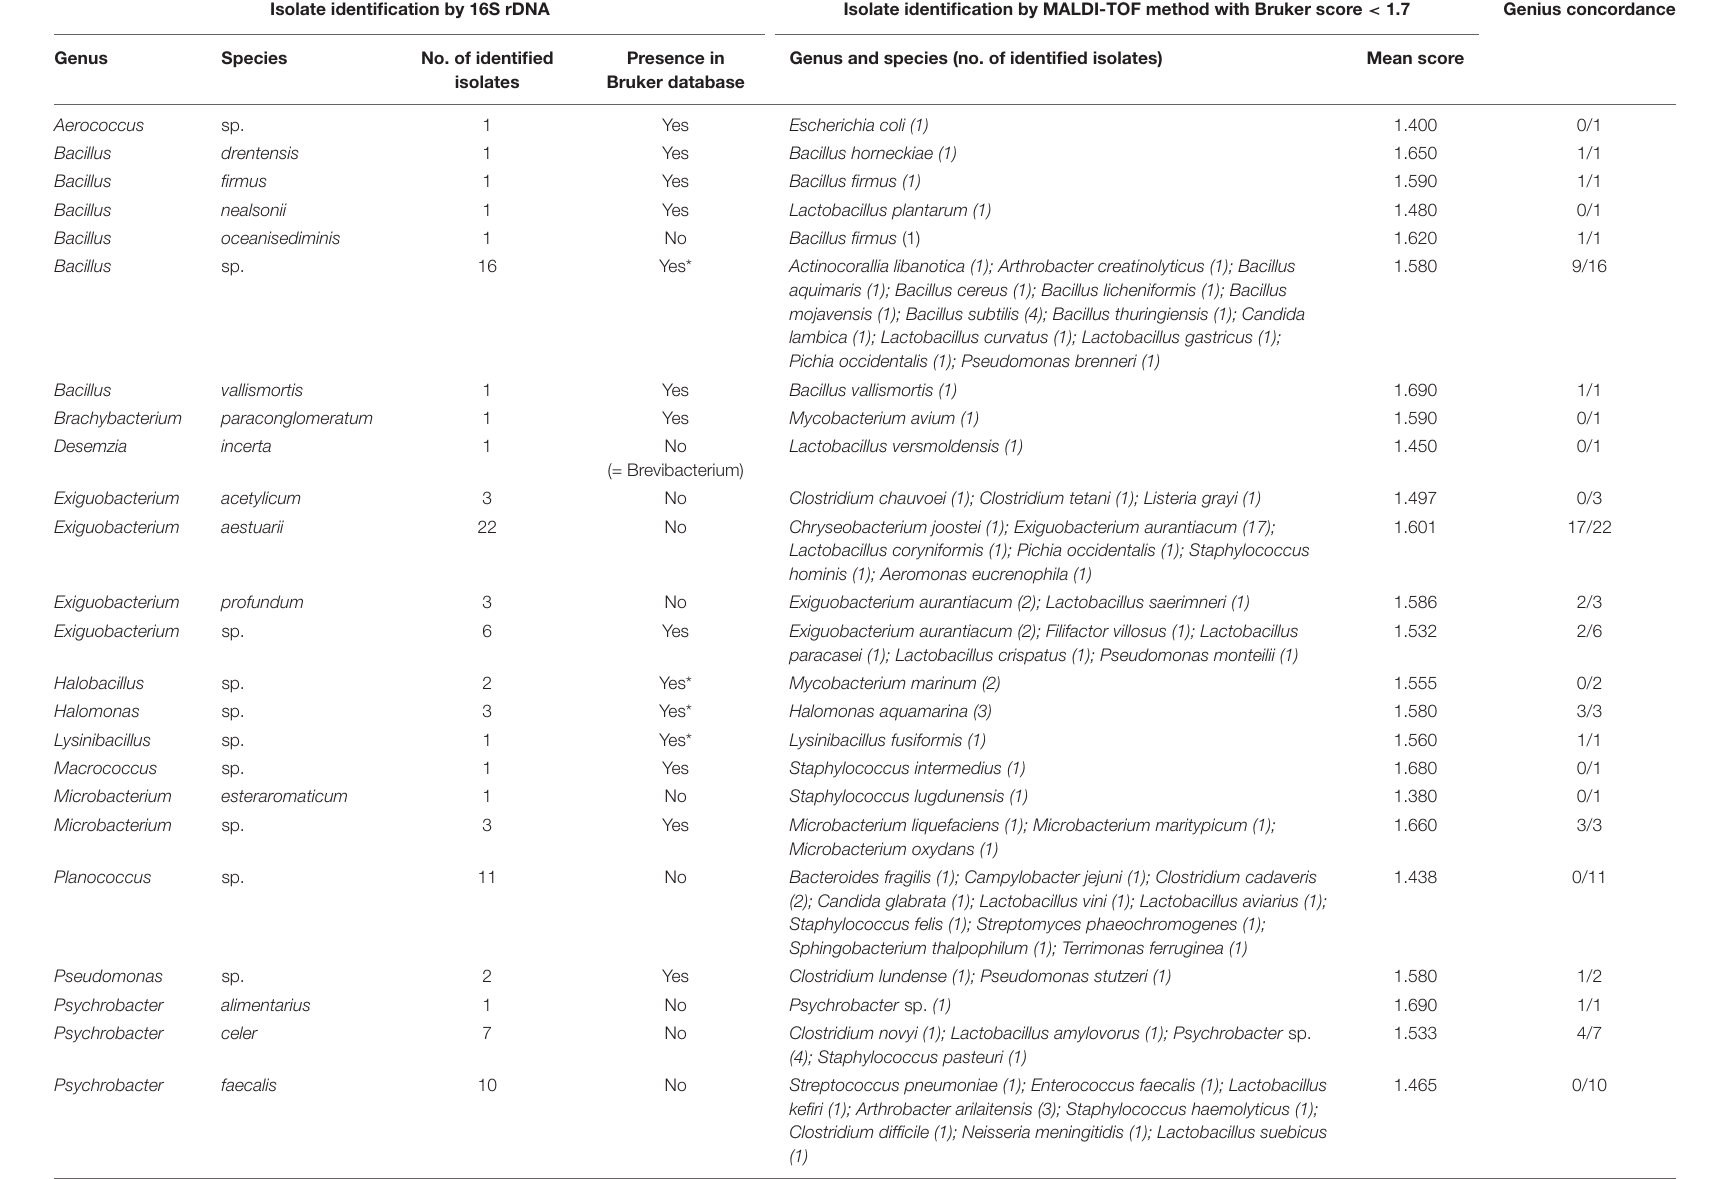
TABLE 4 | Identification of isolates by MALDI-TOF method with Bruker score < 1.7 and 16S rDNA technique. Isolate identification by 16S rDNA Isolate identification by MALDI-TOF method with Bruker score <